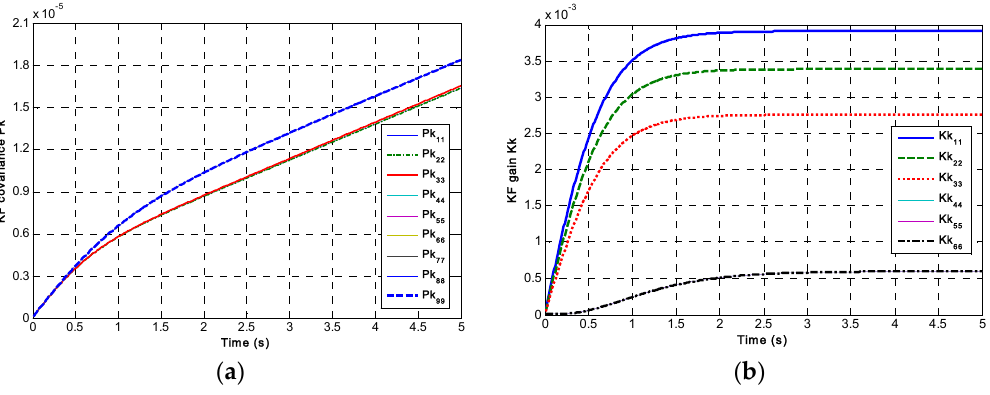
Figure 3. The plot of KF covariance P ( t ) and gain K ( t ): ( a ) P ( t ); ( b ) K ( t ).